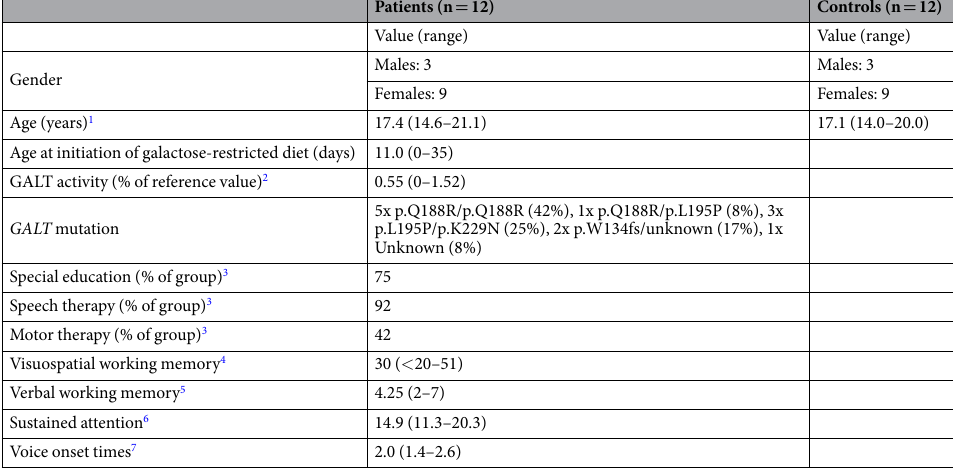
Table 2. Group characteristics. 1: Median age was not significantly different between groups (F 1,22 = 0.12, p = 0.73). 2: GALT enzyme activity measured at diagnosis. 3: Special education, speech therapy or motor therapy at some point in life. 4: Immediate Recall subtest of Rey Osterreith Complex Figure T-score 74 . 5: Digit Span (Forward and Backward) score 75 . 6: Bourdon-Vos mean reaction time 76 . 7: Voice onset times reflecting language production 12